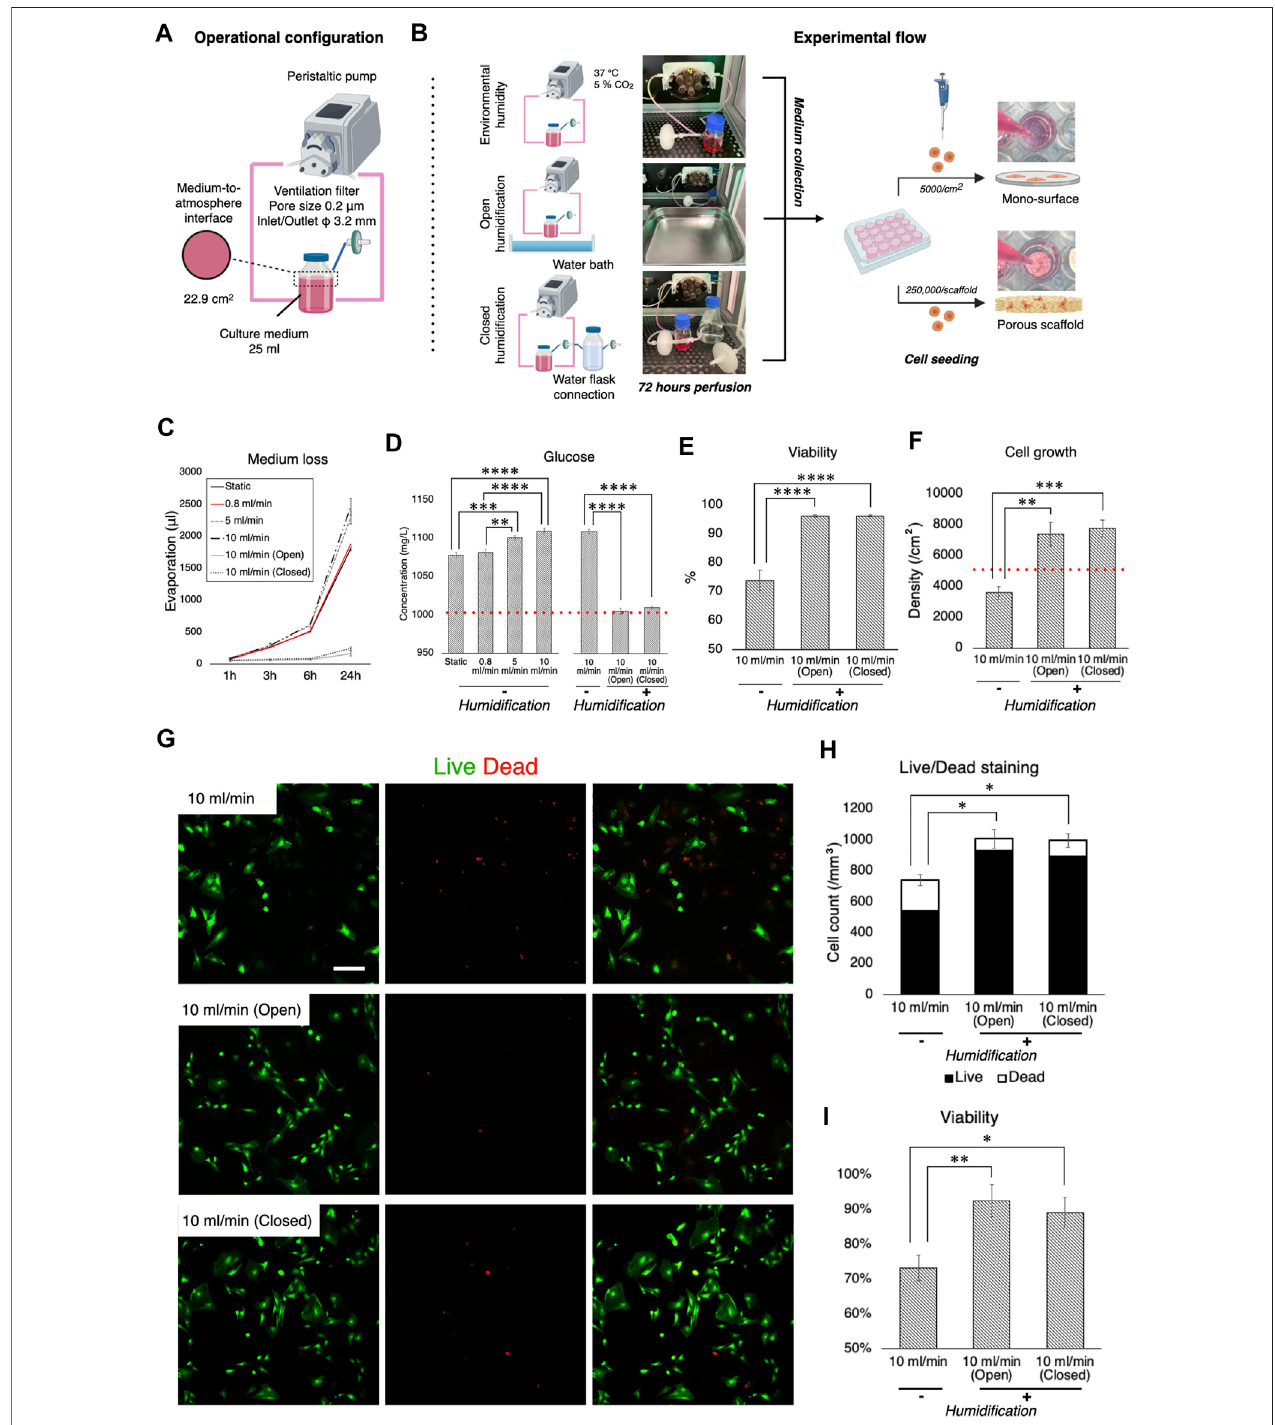
FIGURE 4 | Effect of culture medium loss during perfusion and humidi fi cation. (A) Operational con fi guration for the evaluation of medium loss and humidi fi cation. (B) Illustration of the experimental fl ow. Culture medium, which was perfused with and without humidi fi cation for 72 h, was collected and transferred into cell culture plates where growth of rBMSC on 2D mono-surface and 3D porous scaffolds was observed. (C) Evaporation of culture medium occurred in a velocity dependent manner. Humidi fi cation with a water bath and a water fl ask connection effectively prevented evaporation. (D) Medium evaporation led to the condensation of medium components (e.g., glucose), disrupting osmotic balance. (E,F) On the 2D mono-surface, cell viability and growth of rBMSC incubated in the perfused medium without humidi fi cation deteriorated signi fi cantly. (G – I) Fluorescence images of Live/Dead staining showed that rBMSC incubated in the perfused medium without humidi fi cation signi fi cantly increased the ratio of dead cells, resulting in low cell density and viability on 3D porous scaffolds. * p < 0.05, ** p < 0.01, *** p < 0.001, **** p < 0.0001.